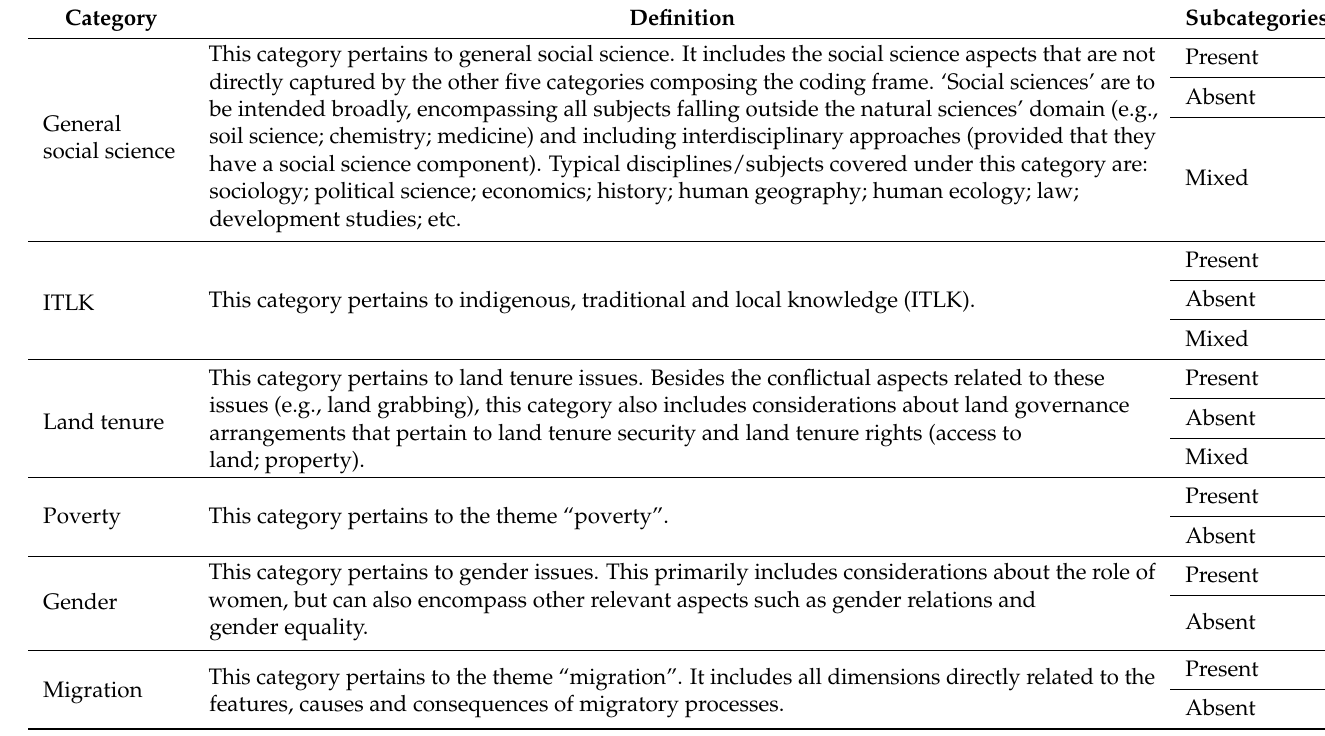
Table 1. Overview of the coding